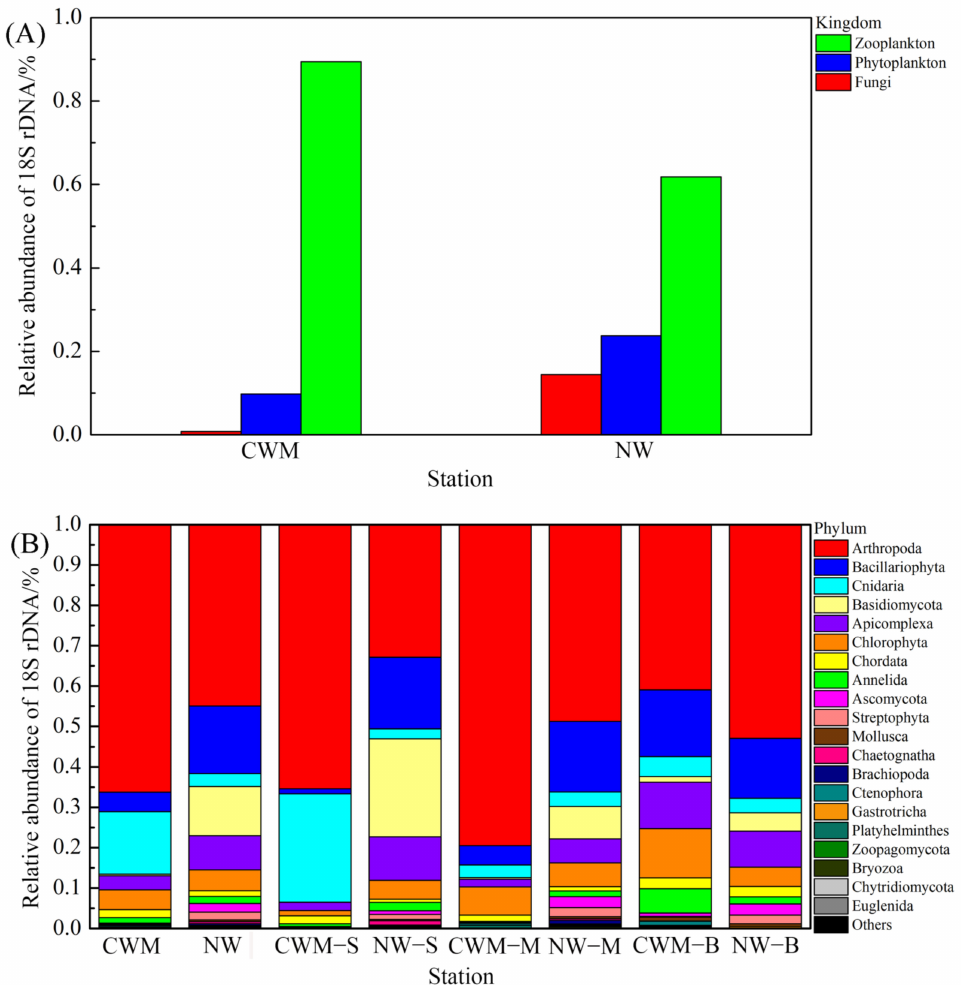
Figure 2. UniFrac UPGMA (unweighted pair group method with arithmetic mean) clustering analysis revealed the dominant plankton kingdoms ( A ) and phyla ( B ) in all samples from different waters of the South Yellow Sea. Cold Water Mass populations (CWM: all; CWM–S: surface; CWM–M: middle; CWM–B: bottom); nearshore waters populations (NW: all; NW–S: surface; NW–M: middle; NW–B: